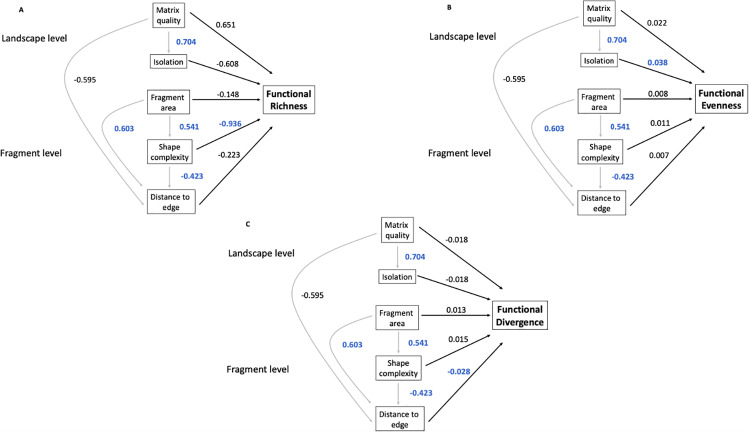
Structural equation models examining the effects of forest fragmentation on functional diversity in the East Usambara Mountains, Tanzania.A) functional richness, B) functional evenness and C) functional divergence. Grey lines represent indirect effects and dark lines representing direct effects. Values associated to lines represent standardized path coefficients. Significant results (p ≤ 0.05) are represented in dark blue.